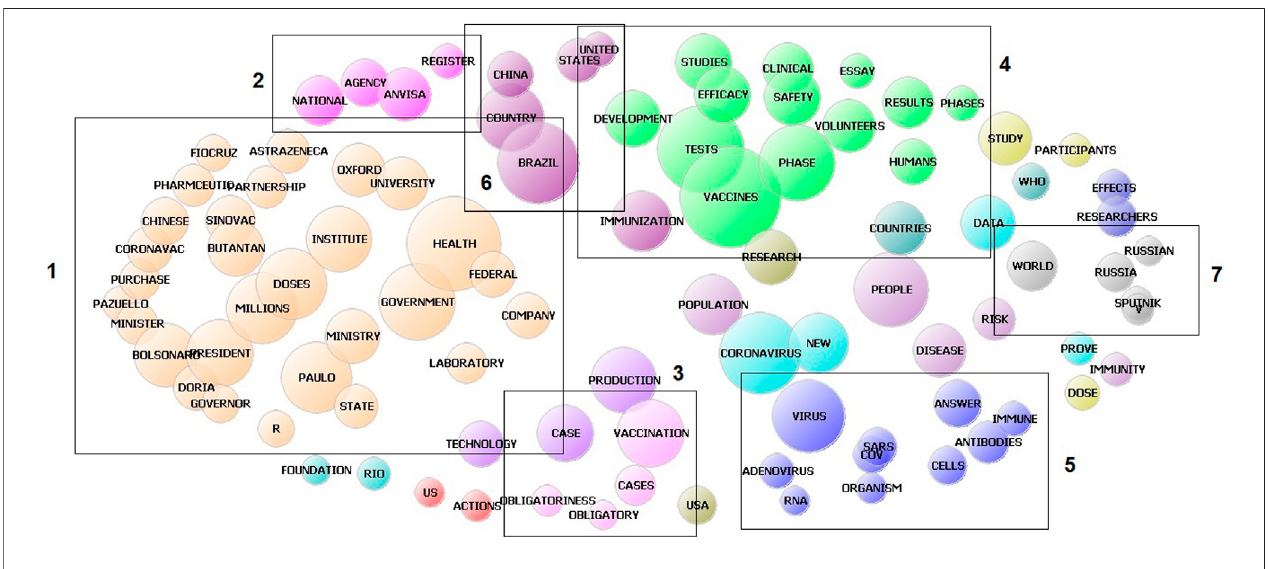
FIGURE 4 | Conceptual map with clustering of Folha de São Paulo .